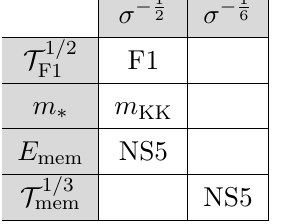
Table 2 . Mass scalings along the flow generated by F1